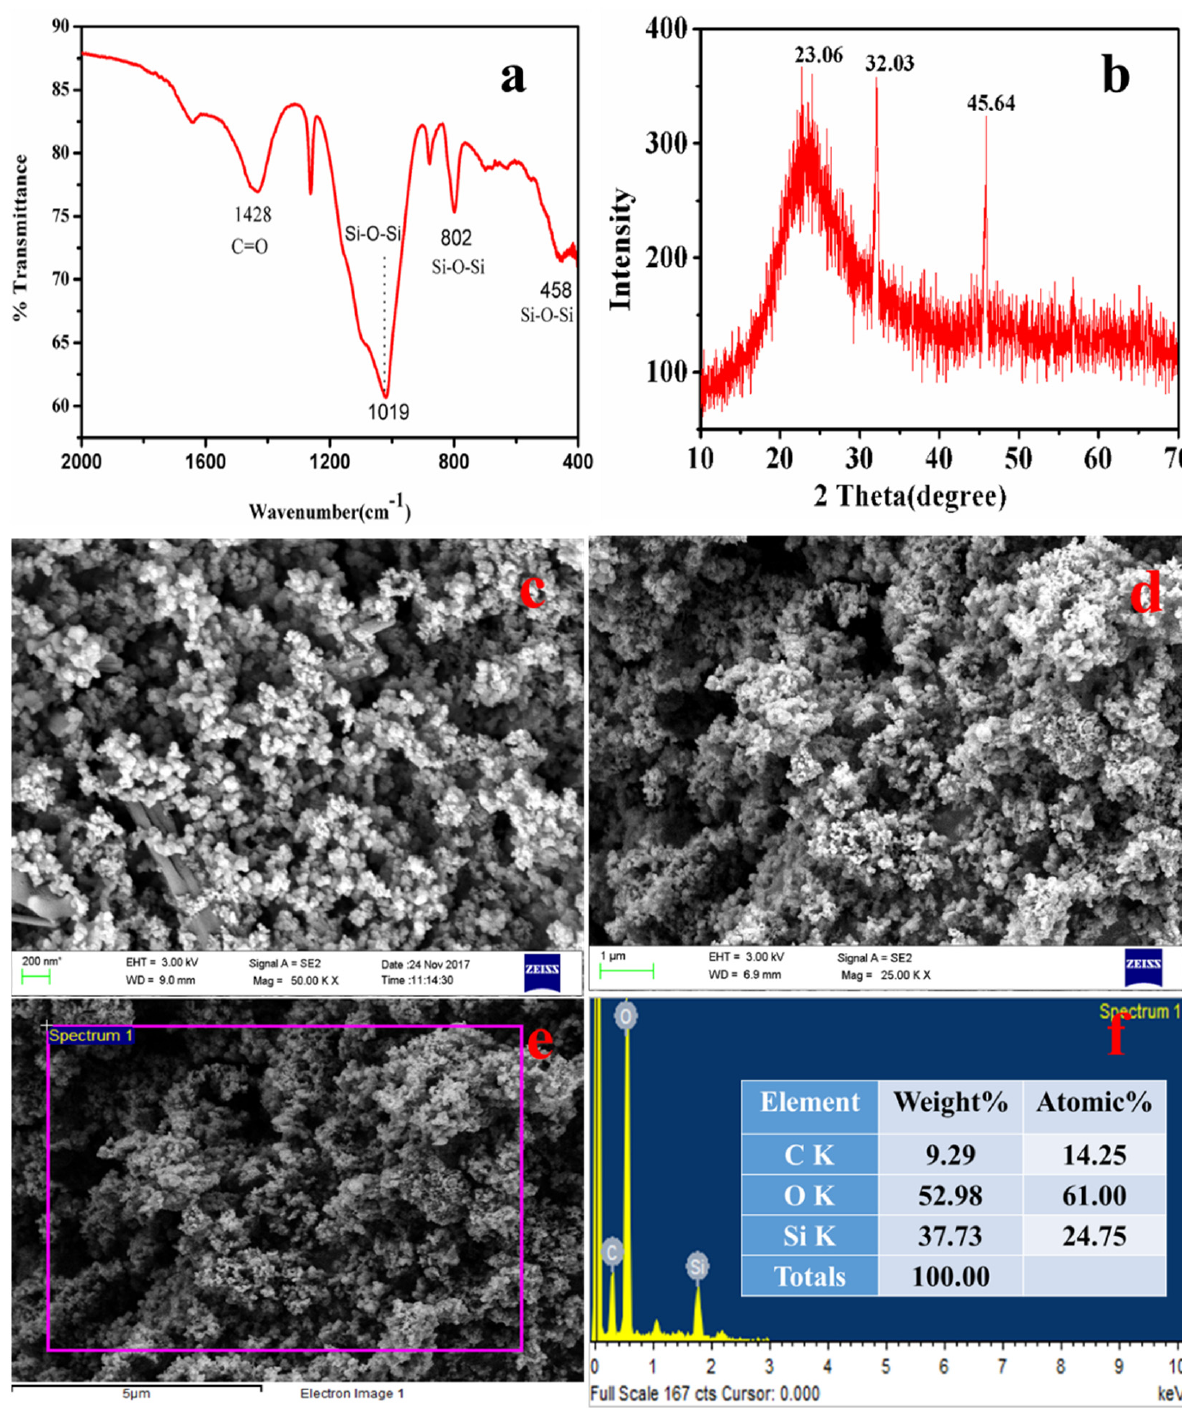
Figure 10. Analysis of silica nanoparticles from ISA: ( a ) FTIR, ( b ) XRD pattern, ( c , d ) FESEM images, ( e ) EDS spot, and ( f ) EDS